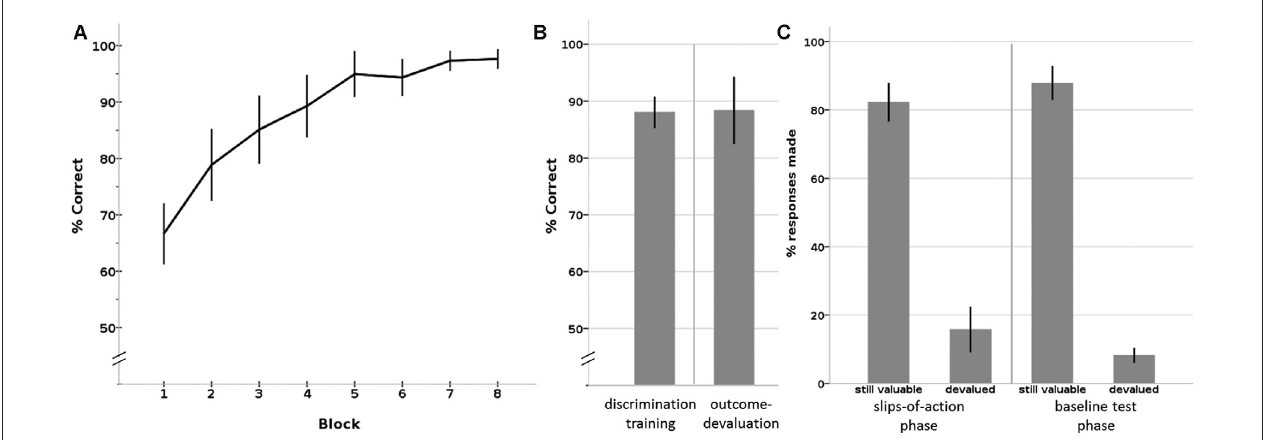
FIGURE 3 | Results of the Instrumental learning task. (A) Instrumental discrimination training phase, displayed as learning over eight blocks. By the eighth block, all participants had learned the correct S-R-O contingencies significantly above chance level. (B) Average percentage correct responses on the (total) discrimination training phase (left) and outcome devaluation phase (right). (C) Percentage responses to still valuable and devalued trials of the slips-of-action phase (left) and the baseline test phase (right). Error bars: 95% confidence interval.